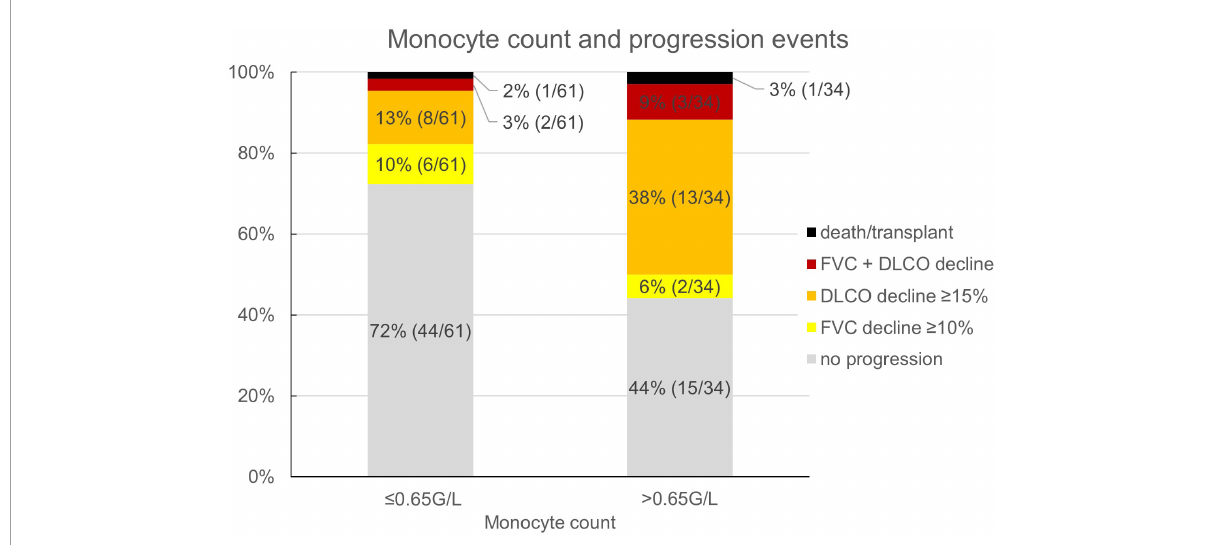
FIGURE3 Monocyte count and fraction (number) of progression events. FVC, forced vital capacity; DLCO, diffusion capacity for carbon monoxide.